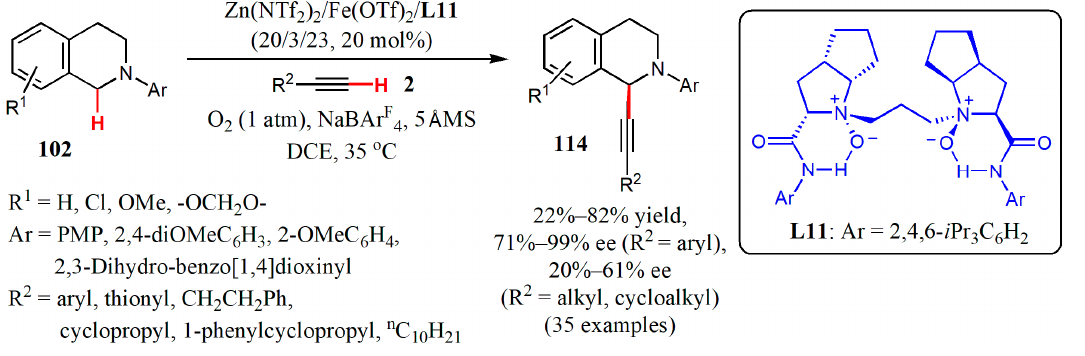
Figure 43. Enantioselective CDC of THIQs with alkynes by dual metal activation.